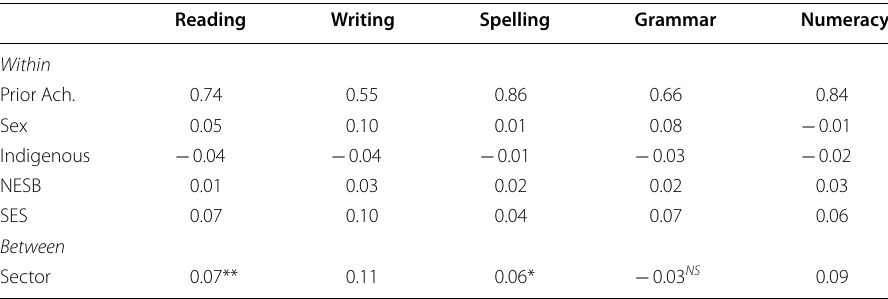
Table 4 Grade nine standardised regression coefficients of control variables